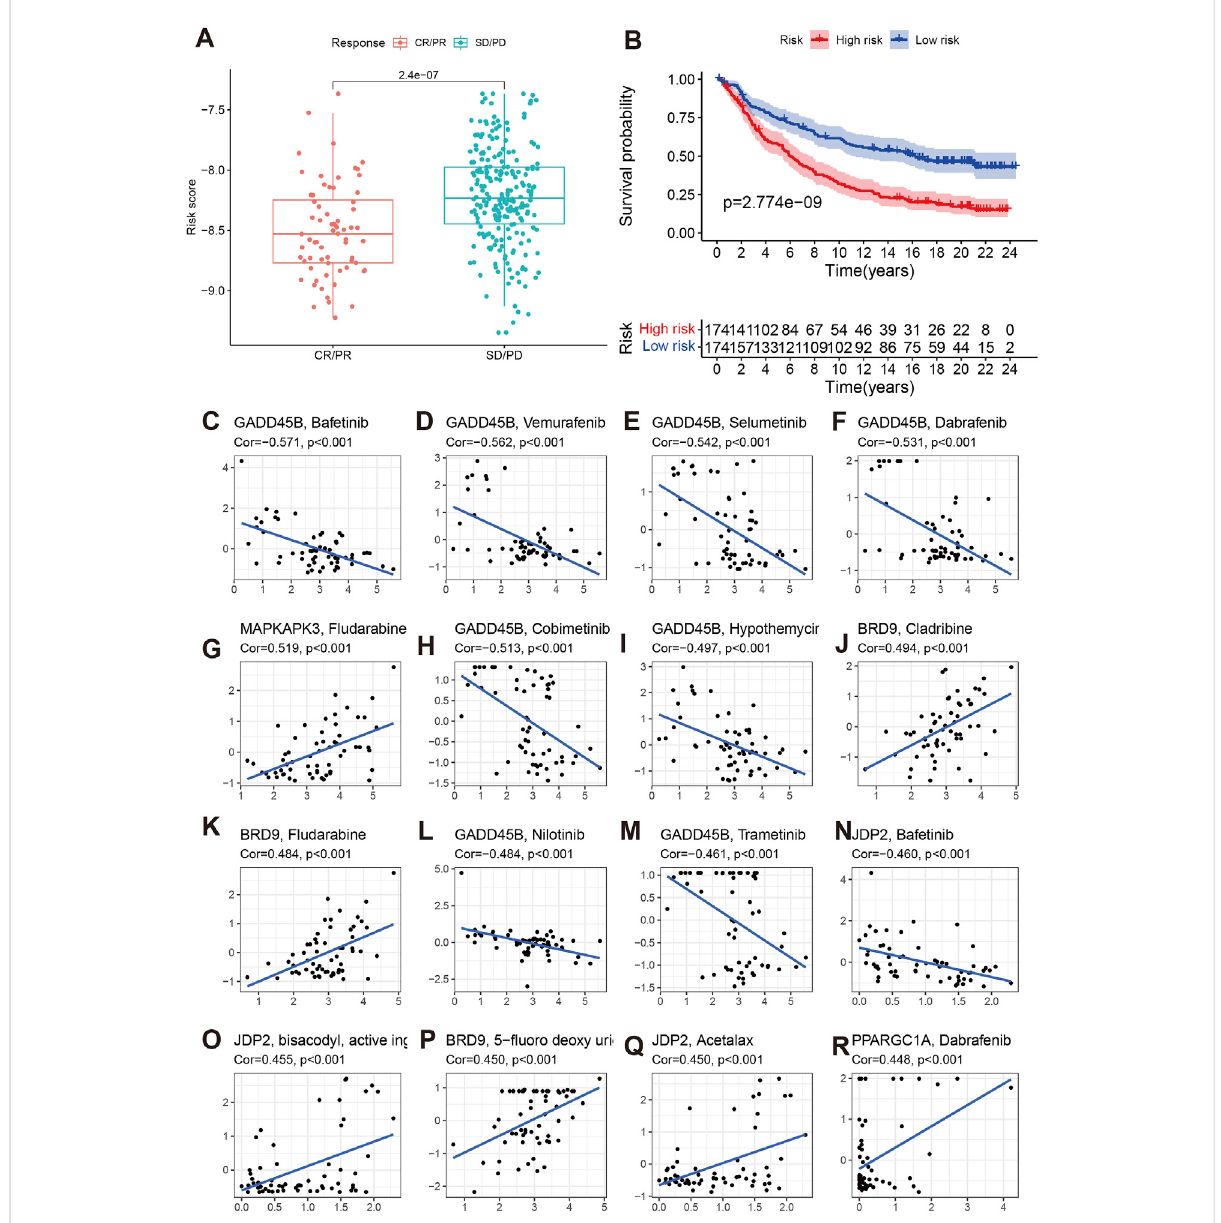
FIGURE 9 Effect of chromatin regulators on immunotherapy of IMvigor data (A,B) of and chemotherapy sensitivity (C – R)